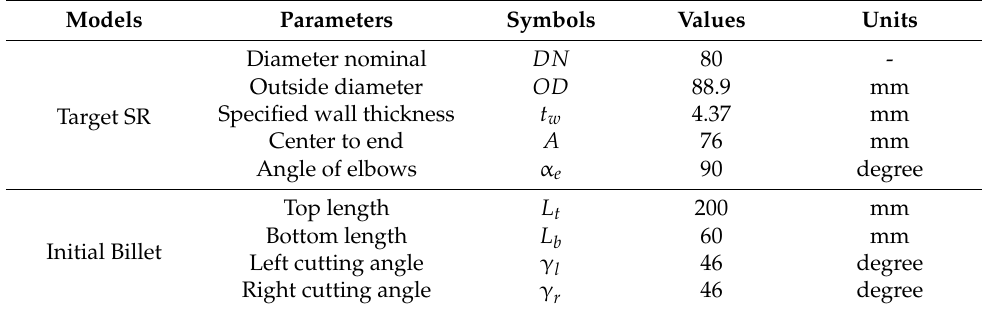
Figure 3. Geometry of initial billet and die: ( a ) target short radius elbow; ( b ) designed initial billet. Table 2. Design parameter of target SR and billet.